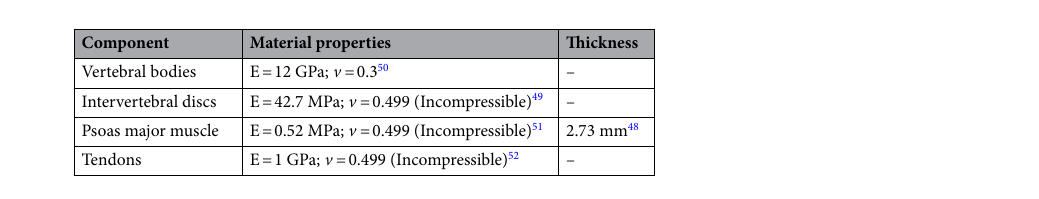
Table 1. Material properties used for the lumbar spine